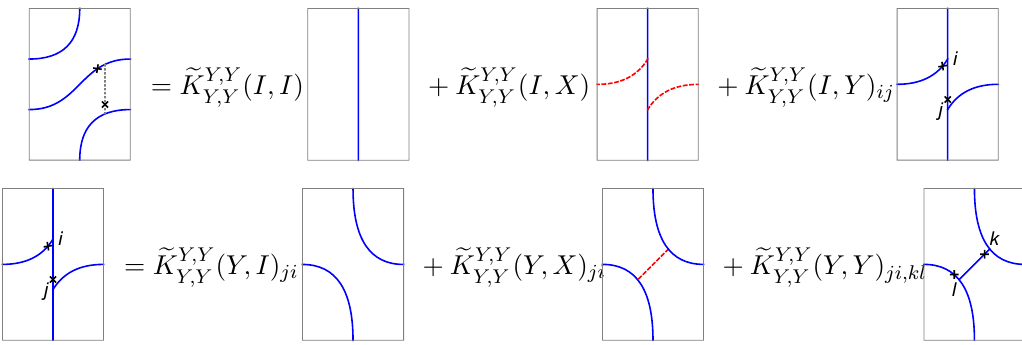
Figure 39 . Derivation of the spin selection rules for the 1 E 6 fusion ring. We apply the H-junction 2 crossing relations to the T 2 and T (cid:0) 2 transformations of a temporal Y line. The blue- and red- dashed lines are used to denote the Y and X lines, respectively. Again, the black-dotted line with crosses labeling the (marked) trivial line in the top left diagram merely keeps track of the crossing kernel applied here, and may be omitted. However, it is important to keep track of the marks on the Y Y Y junctions due to the nontriviality of the cyclic permutation map on V Y;Y;Y .